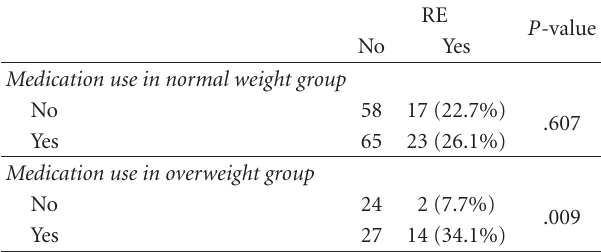
Table 3: Comparison of RE based on antireflux medication use and BMI group.